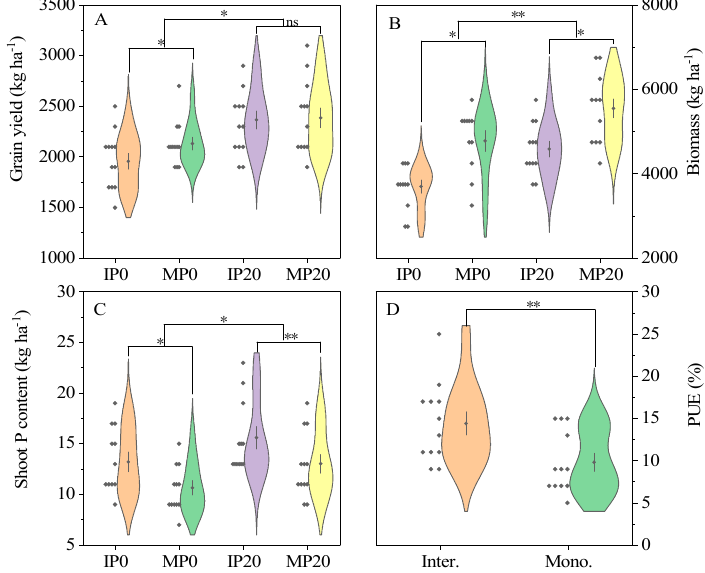
Figure 1. The effect of P (Phosphorus) application and cropping system on soybean ( A ) grain yield, ( B ) biomass, ( C ) shoot P content, and ( D ) PUE (P fertilizer-use efficiency) in the field experiment from 2016 to 2019. IP0: soybean was grown in inter-cropping without P application; MP0: soybean was grown in monocropping without P application; IP20: soybean was grown in inter-cropping with 20 kg P ha − 1 application; MP20: soybean was grown in monocropping with 20 kg P ha − 1 application; ** means the difference between treatment was significant ( p ≤ 0.01) by “ t ” test; * means the difference